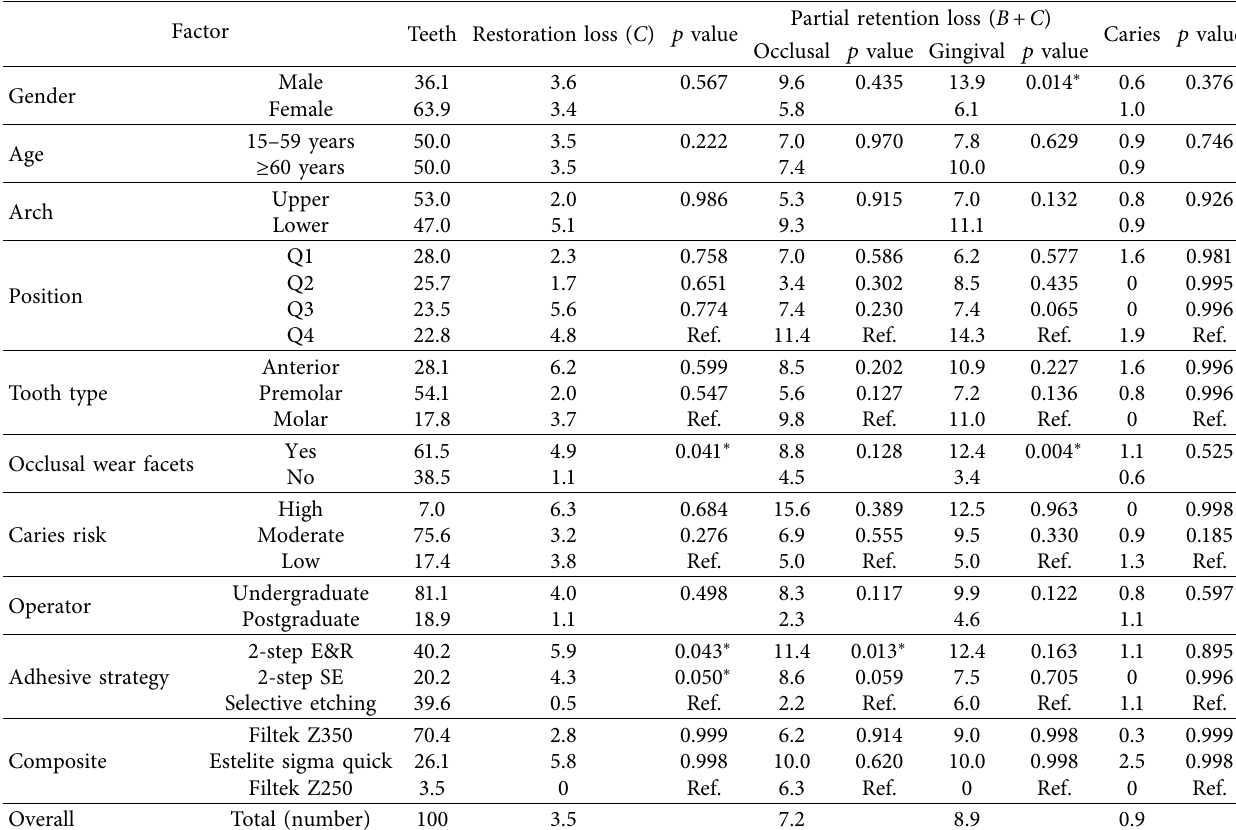
Table 2: Distribution of the restorations, restoration loss, partial retention loss, and caries failure related to various factors presented as percentages.